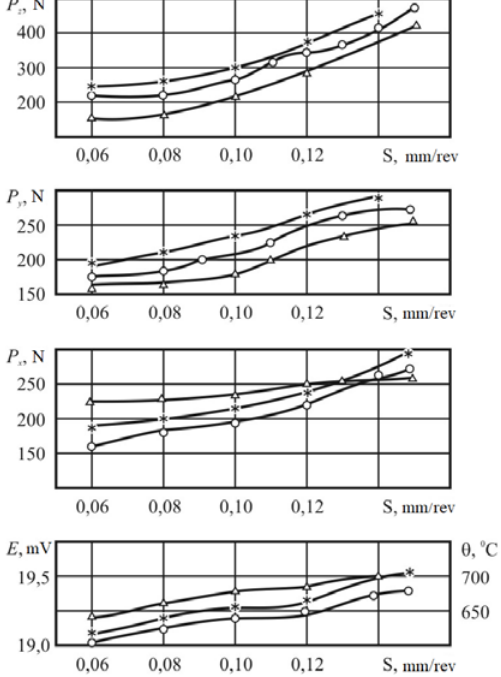
Fig. 2. Dependence of the components of the cutting force, thermo-EMF and temperature on the cutting speed when turning EI698-VK8 (- aS> 0; - aS <0; - aS <0; V = 0.66 m / s; t = 0.5 mm)